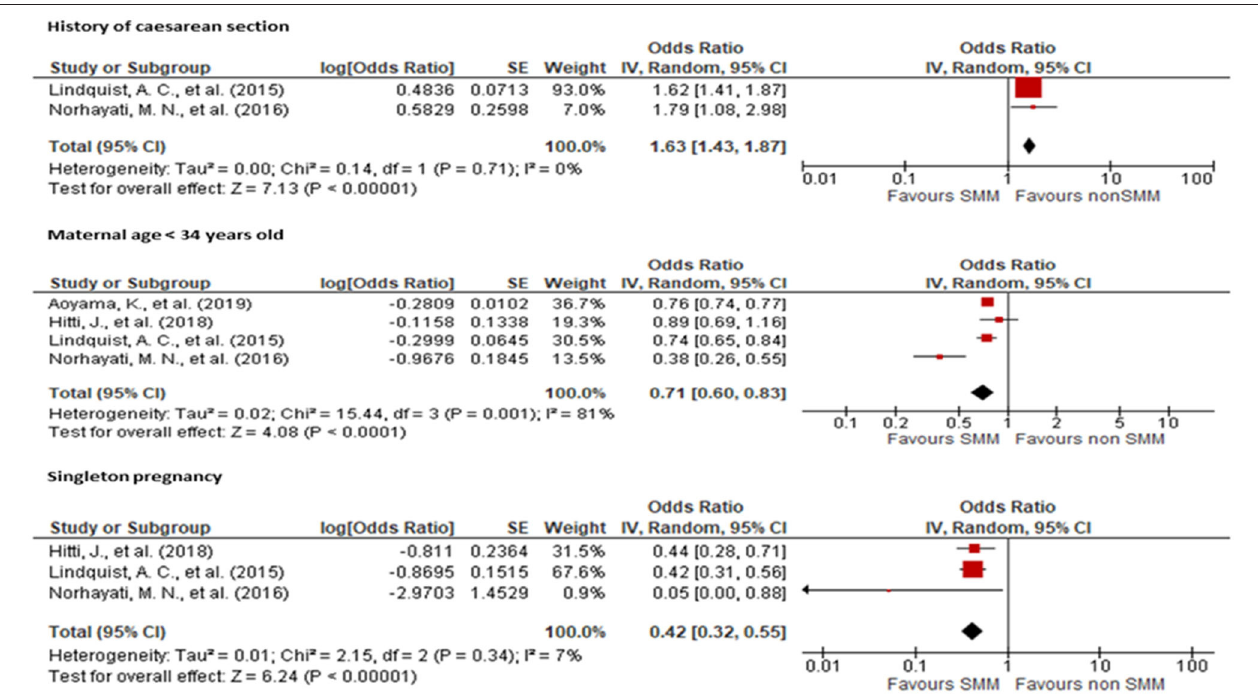
FIGURE 3 | Forest plot showing the association of history of cesarean section, maternal age, and singleton pregnancy with severe maternal morbidity.